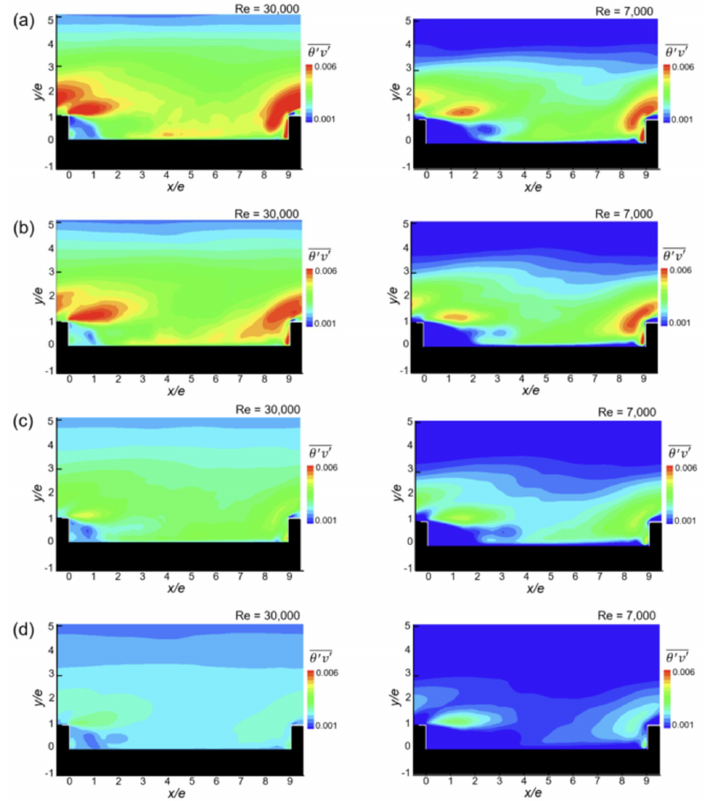
Figure 8. Turbulent heat flux distributions for ( a ) K * = 566.26, ( b ) K * = 100.00, ( c ) K * = 10.00, and ( d ) K * = 1.00. The turbulent heat flux near the wall is closely related to the heat transfer [27]. A region of low turbulent heat flux exists near the wall at 0 < x/e < 2, where the recirculation flow exists, and at Re = 7000, this region extends downstream. When K * is large (Figure 8a,b), a region with a large turbulent heat flux is observed on the channel wall, where 4 < x/e < 6, at Re = 30,000. These regions are not clearly observed when K * is small or Re = 7000. Figure 9 compares the temperature fluctuations according to the Reynolds number and thermal conductivity ratio. Except when K * = 1, most temperature fluctuations occur in the fluid region, and the fluid region appears in red. The situation at Re = 7000 is similar to that at Re = 30,000, but the fluctuations in the solid are slightly larger. As K * decreases or Re decreases, the temperature fluctuations inside the solid increase, so a fully coupled simulation that analyzes the conduction and flow in the solid in real time has more justi- fication.